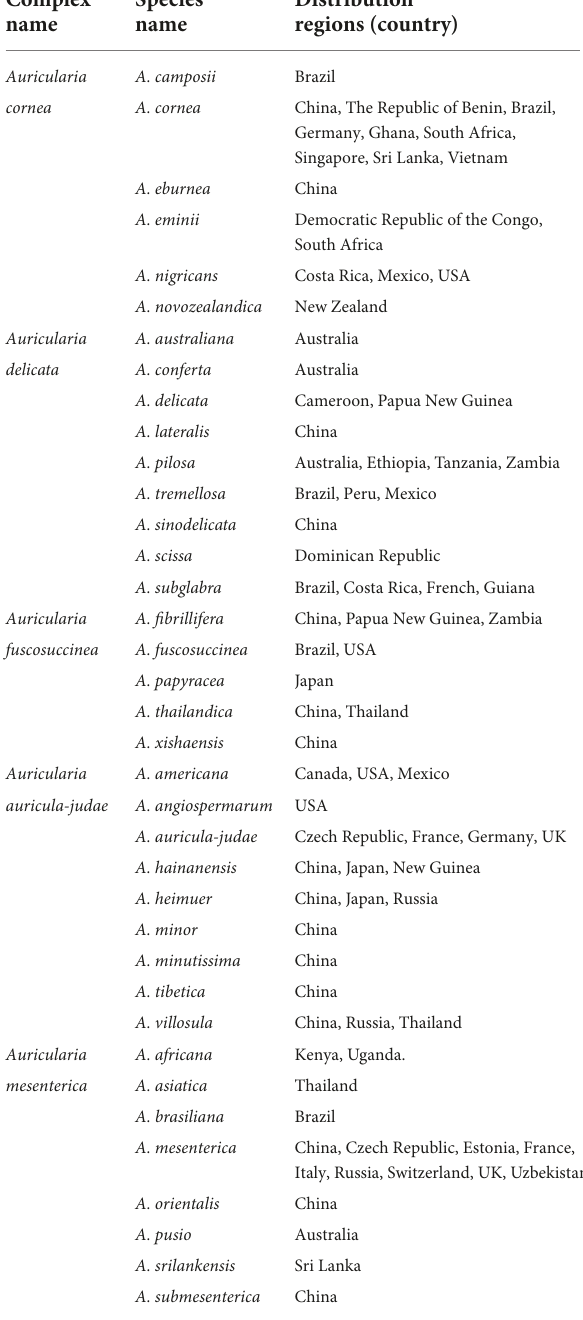
TABLE 1 Global distribution of Auricularia